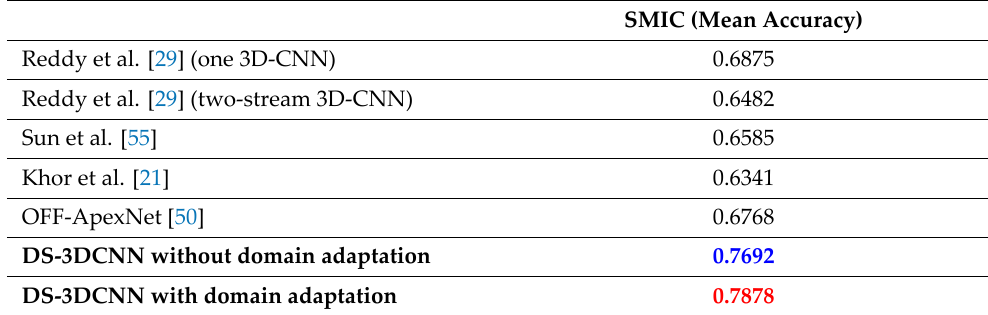
Table 6. Comparison of mean accuracy between two proposed models and other models on the SMIC dataset.